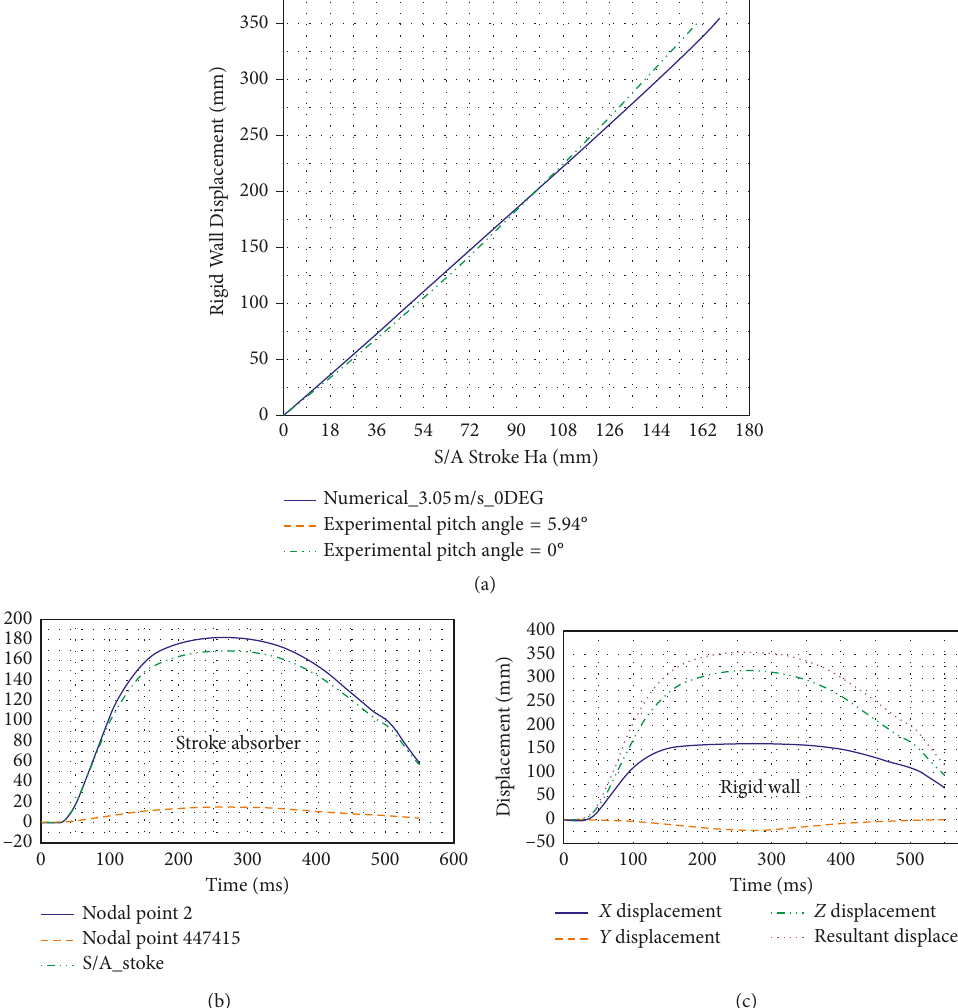
Figure 29: (a) Shock absorber stroke vs. rigid wall displacement curves; (b) shock absorber stroke vs. time curves; (c) rigid wall displacement vs. time